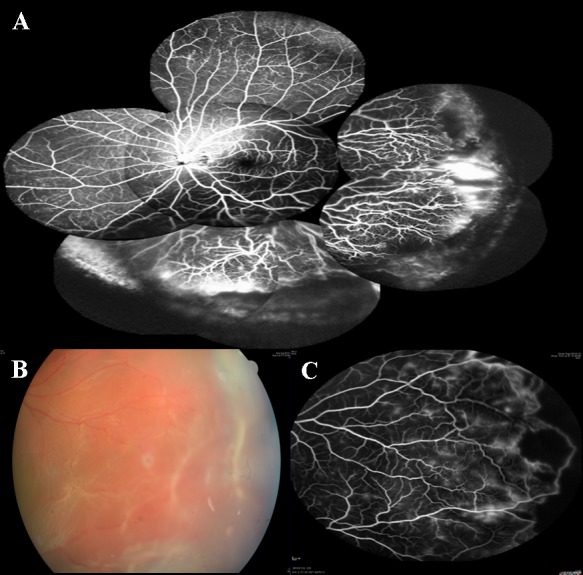
Color fundus and FA pictures of group 2 eyes (A) Fluorescein angiography of an eye with group 2 retinal vasculature. Note there is an abrupt cessation of temporal and lower peripheral retinal vasculature, leaving a wide area of peripheral non-perfusion. Marked leakage is noted at the temporal and lower detached retina. Some microaneurysms are noted in the nasal peripheral, attached retina. (B) Magnified color fundus showing lattice degeneration at temporal aspect in the same patient. (C) Fluorescein angiography at the same location showing the lattice degeneration situated just beyond the vascular cessation. Terminal dilatation, vascular tortuosity and telangiectatic vessels were also noted